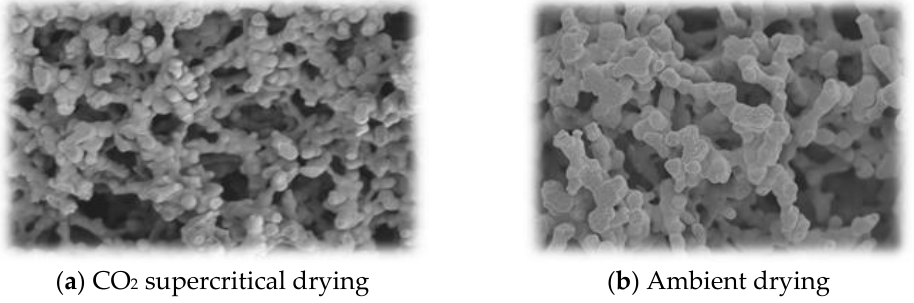
Figure 2. Comparison of polybenzoxazine aerogels prepared by ( a ) supercritical drying and ( b ) ambient drying showing the similarity of the microstructure. (Reproduced from the work in [36] with permission).